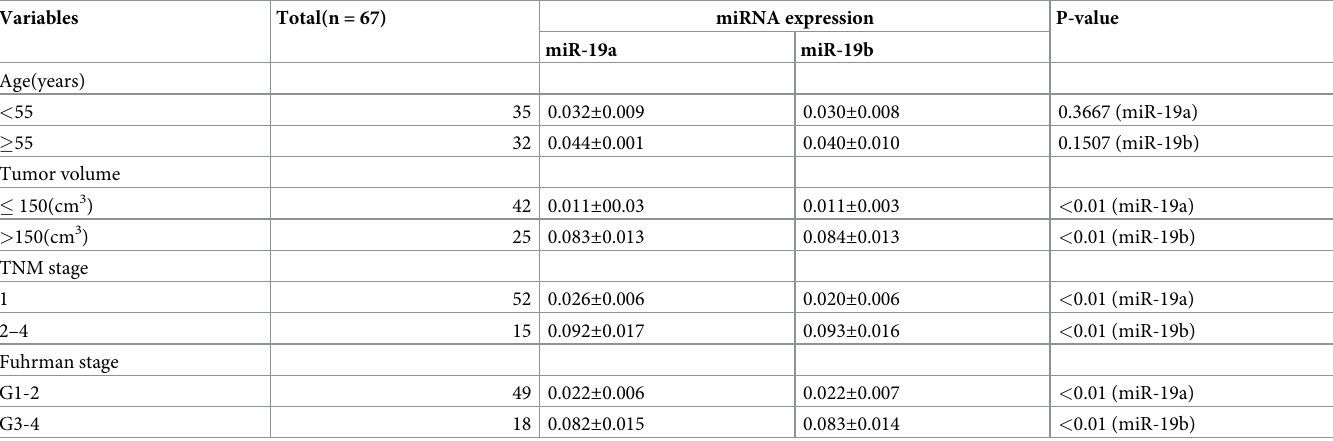
Table 1. The correlation between miR-19a and miR-19b expression and clinical and pathological parameters of ccRCC patients.